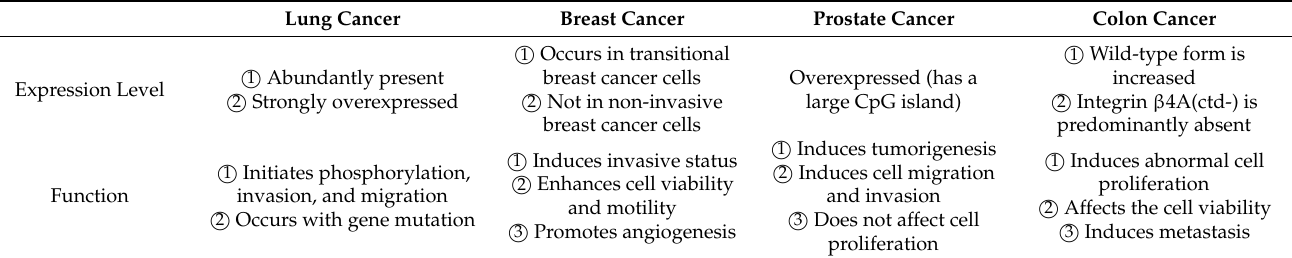
Table 1. Expression level and function of integrin β 4 in different cancers. Lung Cancer Breast Cancer Prostate Cancer Colon